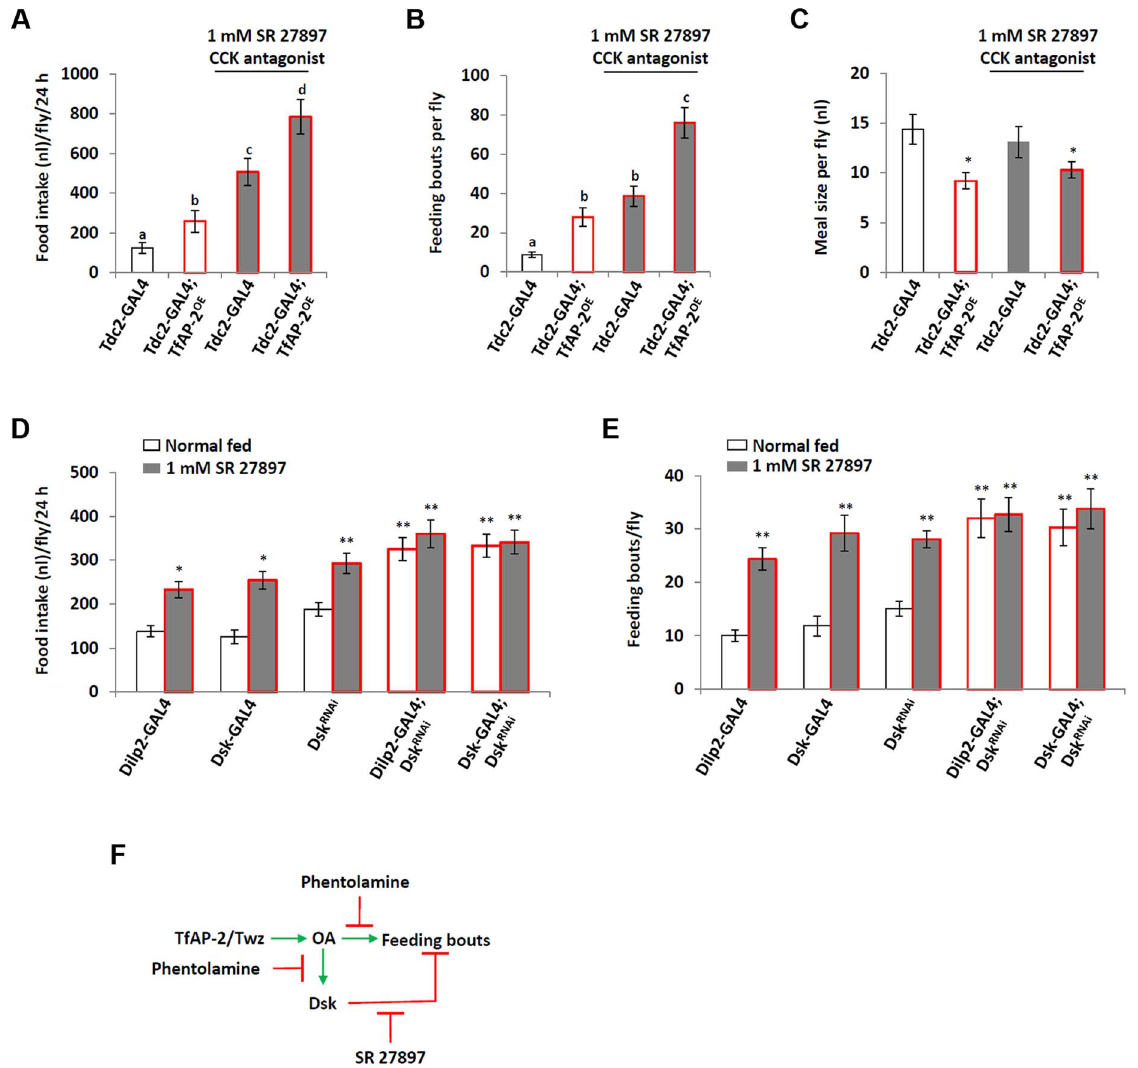
Figure 6. Dsk signals to inhibit feeding. (A–C) Male flies were fed 1 mM of the CCK antagonist SR 27897 before a CAFE assay was performed. (A) Feeding control and TfAP-2 OE males SR 27897 increased total food intake, (B) and the number of feeding bouts, but (C) did not have an effect on the average meal size. Five males were used for each replicate and the assay was repeated at least 10 times (D,E) Knocking down Dsk in either the insulin- producing cells or all Dsk expressing cells inhibits the increase in total food intake (D) and feeding bouts (E) observed when flies are fed 1 mM of the CCK antagonist SR 27897. (F) Schematic drawing of octopamine and Dsk feedback lop to regulate the number of feeding bouts. Phentolamine is an octopamine antagonist, SR 27897 is a mammalian CCK antagonist. In A and B, different letters indicate similar groups (i.e. ‘a’ is significantly different than ‘b’ or ‘c’ and so on, A non-parametric Kruskal-Wallis ANOVA was performed with Dunn’s post hoc test for multiple comparisons, P , 0.05). In C a single asterisk indicates significant difference from the Tdc2-GAL4 normal fed control (A non-parametric Kruskal-Wallis ANOVA was performed with Dunn’s post hoc test for multiple comparisons, P , 0.05). In D and E a double asterisk indicates significant difference from the Dilp2-GAL4 normal fed control (A non-parametric Kruskal-Wallis ANOVA was performed with Dunn’s post hoc test for multiple comparisons, P , 0.005). Error bars represent the SE (SEM).